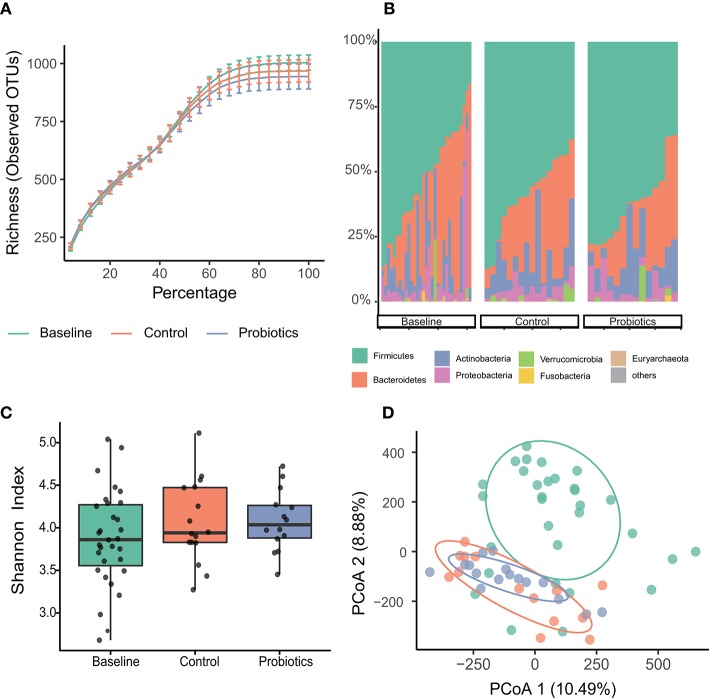
Microbial variations of fecal samples from the third trimester. (A) Species accumulation and rarefaction curves calculated for each group. (B) Relative abundance of bacterial phyla for each group. (C) Alpha-diversity estimated by Simpson indices showed no difference in groups. (D) Principal coordinates analysis (PCoA) based on Manhattan distances with ellipses representing 68% confidence intervals. Baseline vs. control: p < 0.001; baseline vs. probiotics: p < 0.001; control vs. probiotics: p = 0.464. Statistical significance was determined by the Adonis test (Vegan, R script package).